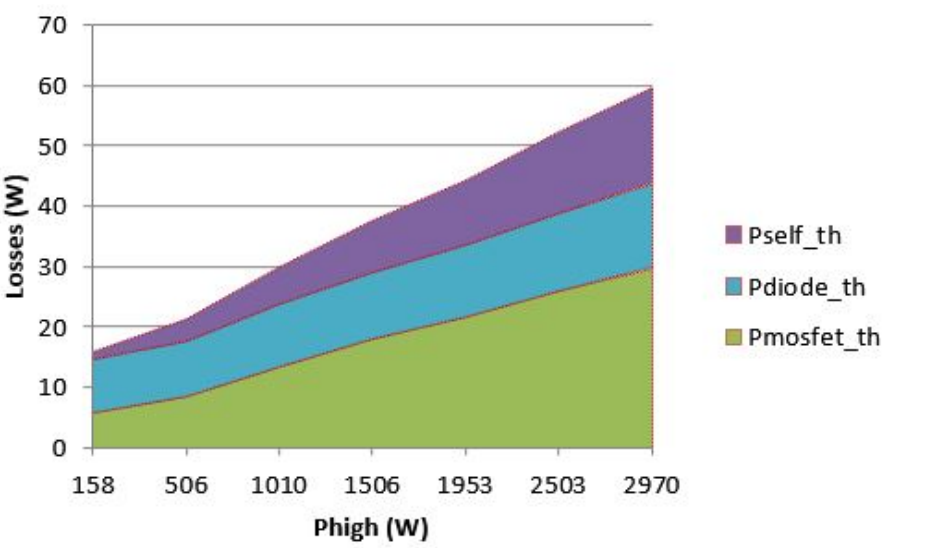
Figure 13. Repartition of the losses inside a phase of the 3-Phase IBC prototype according to opti- mization model.